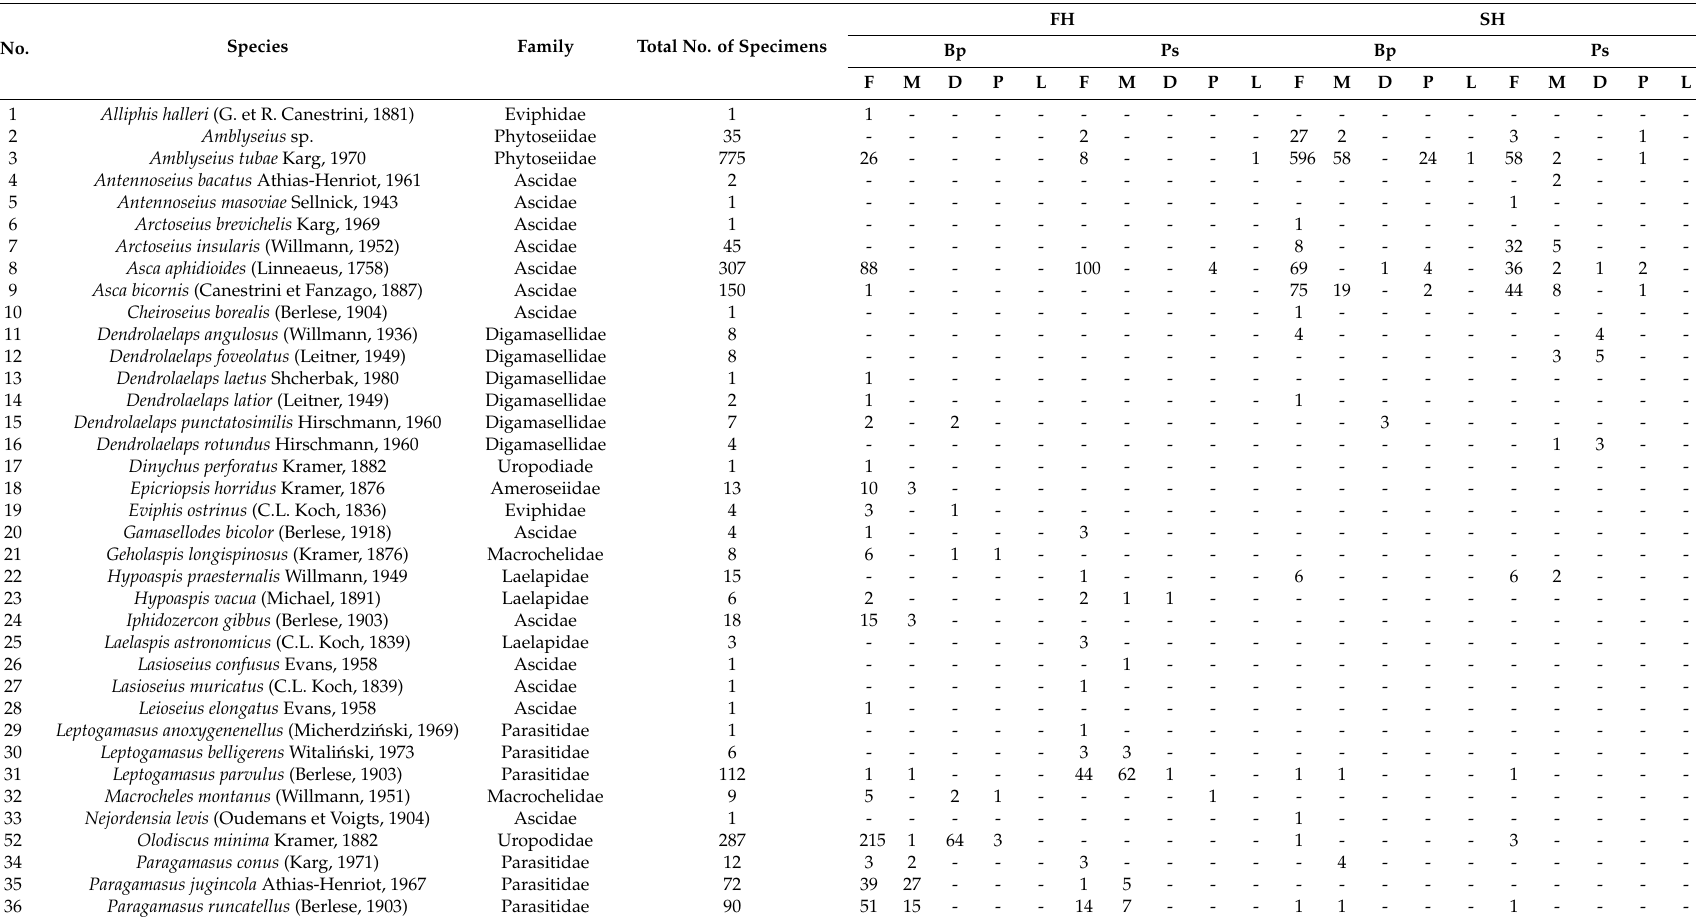
Table A4. Checklist of mite species with number of individuals in Betula pendula (Bp) and Pinus sylvestris (Ps) stands growing in forest habitat (FH) and spoil heap (SH). The “-” signs were given to make the data table more transparent and should not be equated with the lack of results. Abbreviations: F—females, M—males, D—deutonymphs, P—protonymphs, L—larvae.